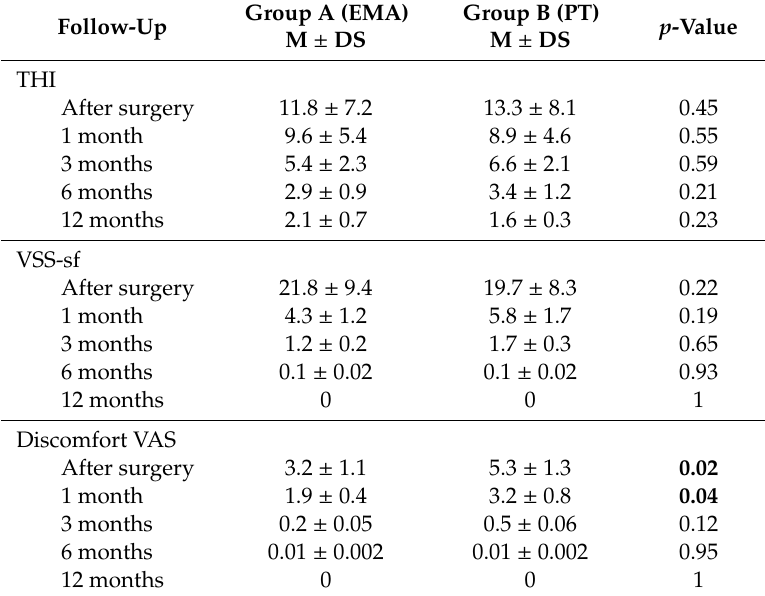
Table 3. THI, VSS-sf, and VAS discomfort postsurgery and after 1, 3, 6, and 12-month